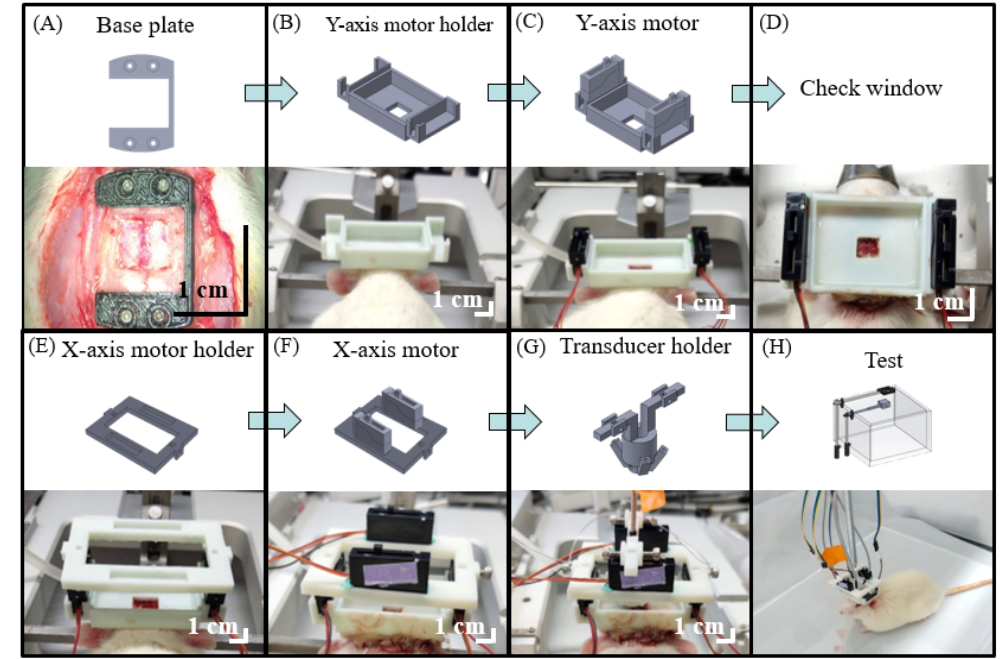
Figure 4. Surgical preparation procedure for the developed hmPAI system for the rat brain. ( A ) The base plate is used to set set screws in the skull. ( B ) The y -axis motor bracket slides into the base plate through the track. ( C ) The y -axis motor is set in the y -axis motor holder with four screws. ( D ) The user checks the window to ensure that the surgical area is visible. ( E ) The x -axis motor holder is set in the y -axis motor with two screws. ( F ) The x -axis motor is set in the x -axis motor holder with four screws. ( G ) The transducer holder is set in the x -axis motor with two screws. ( H ) Test of the developed hmPAI system with awake rats in an acrylic box.